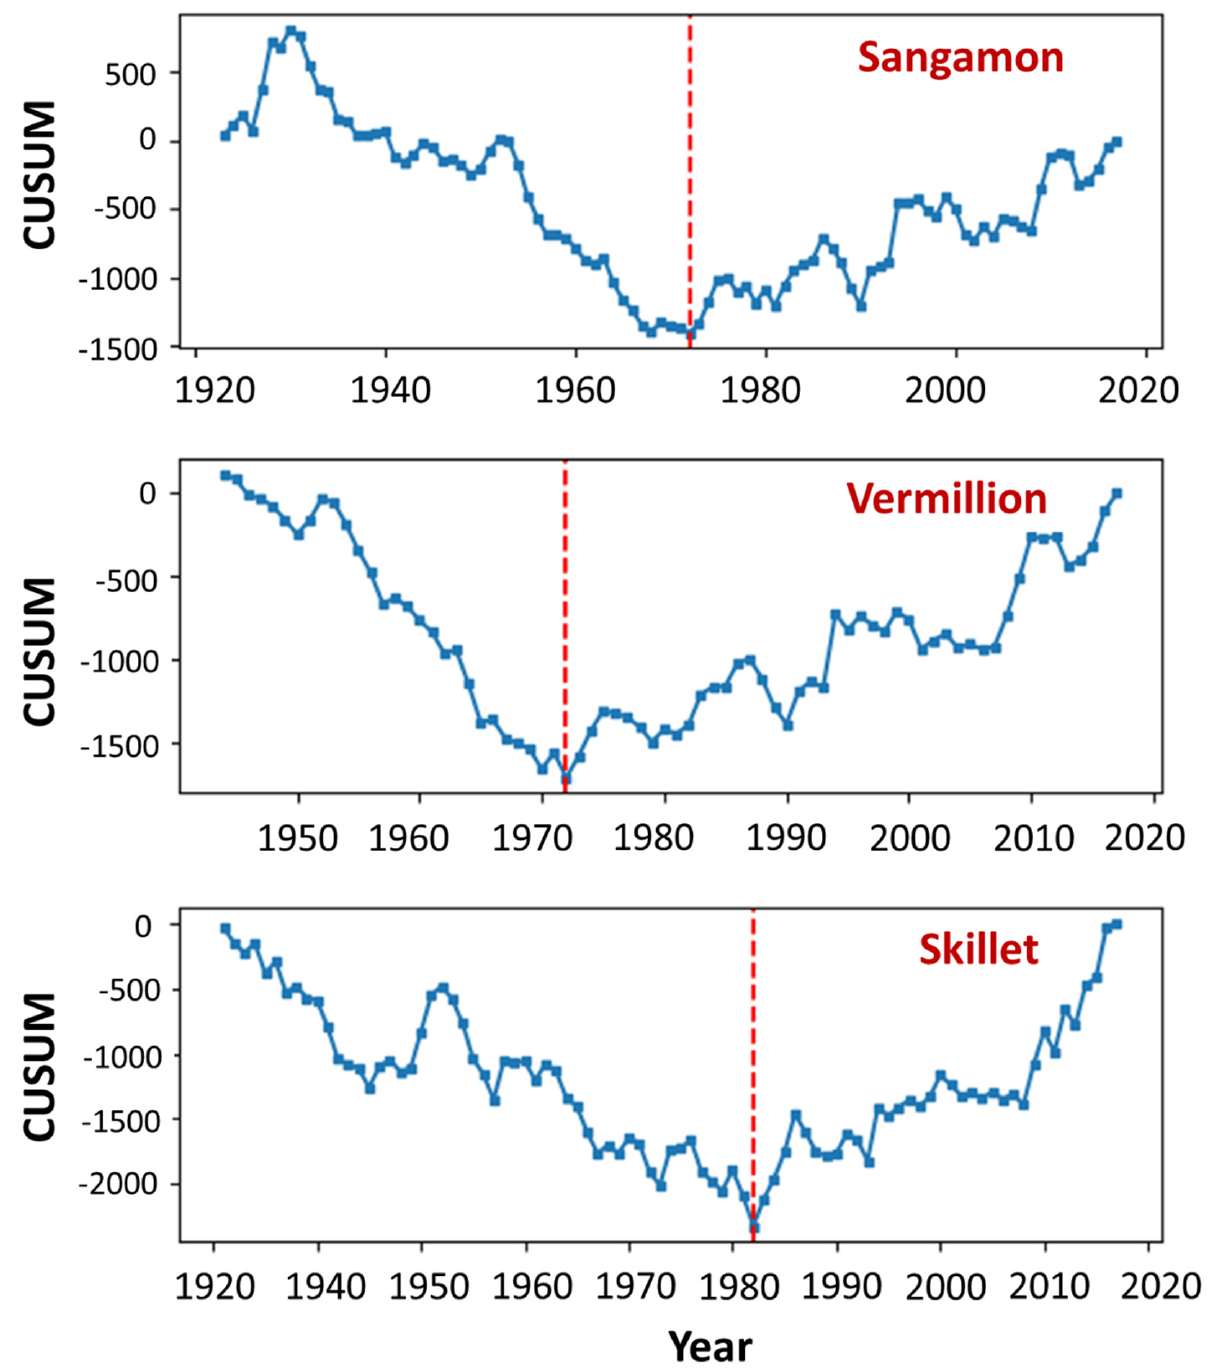
Figure 6. CUMSUM chart for the Sangamon, Vermillion and Skillet watersheds.